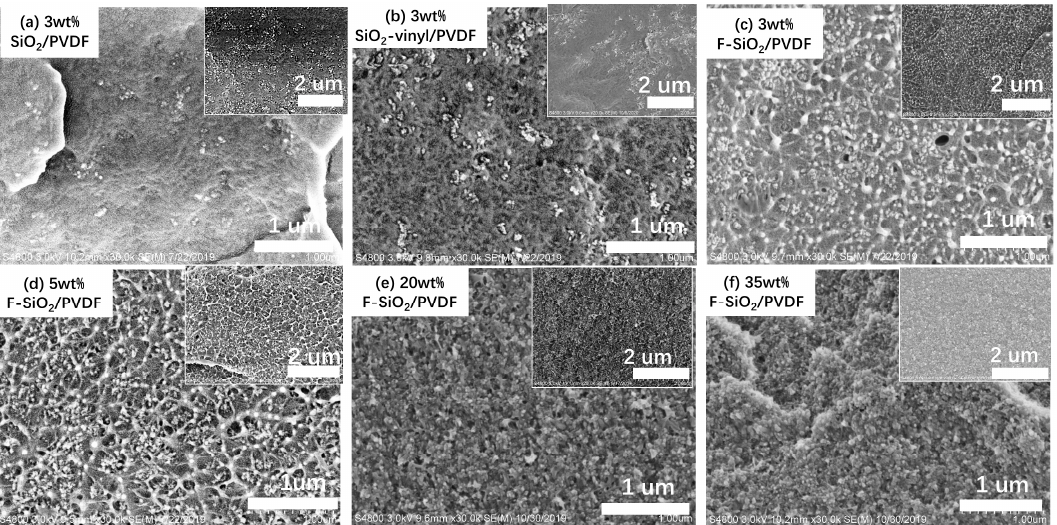
7 Figure 7. SEM images of the PVDF matrix incorporated with 3wt%, ( a ) pristine SiO and ( c ) F-SiO 2 nanoparticles, respectively. SEM images of PVDF matrix incorporated 5 wt% ( d ), 20 wt% ( e ), 35 wt%, and ( f ) F-SiO 2 nanoparticles,